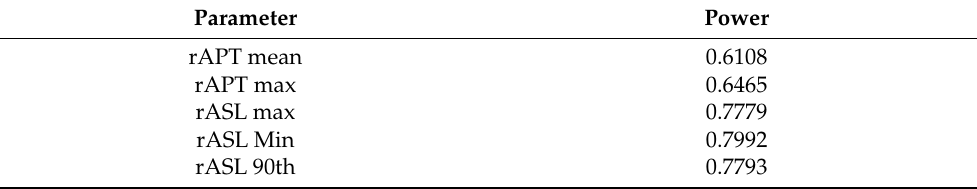
Table 2. The power values for sample size